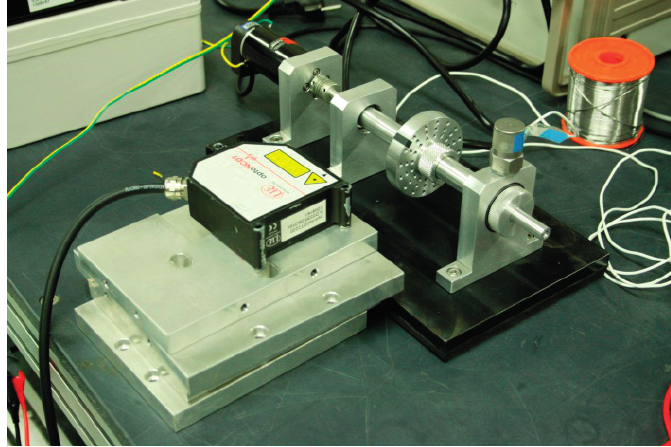
Figure 2. A roller bearing system with driving motor and acceleration sensor instrumentation.